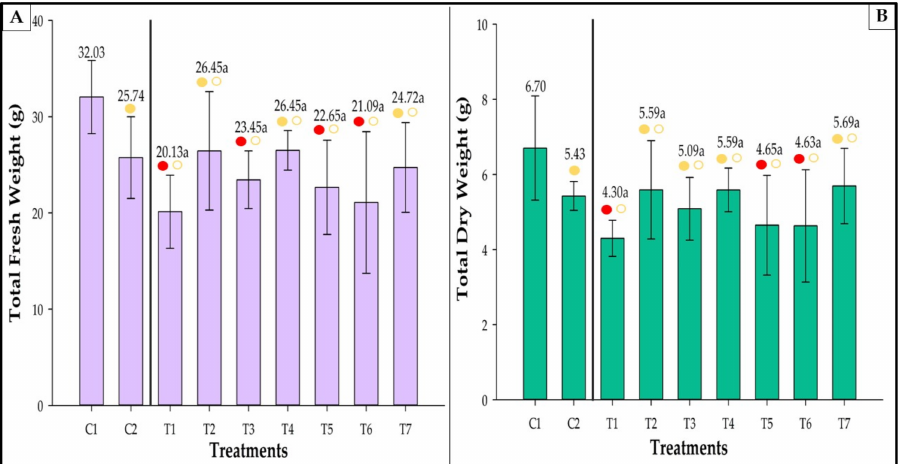
Figure 9. Total fresh ( A ) and dry ( B ) weights of strawberries inoculated with Azospirillum brasilense , Bacillus megaterium , and Brevibacillus fluminis , alone and in mixtures. Closed ( indicate comparisons withs Controls 1 and 2, respectively. Yellow and red circles indicate that the values are equivalent to, or lower than those observed in the controls according to Dunnet’s test ( p ≤ 0.05). Means followed by the same letter do not differ statistically according to Duncan’s test ( p ≤ 0.05). C1: control without inoculation + fertilization 100% of N and P; C2: control without inoculation + fertilization 30% of N and P; T1 : Azospirillum brasilense (Ab-v5); T2: Bacillus megaterium (0004); T3: Brevibacillus fluminis (MET12M2); T4: Ab-v5 + 0004; T5: Ab-v5 + MET12M2; T6: 0004 + MET12M2; T7: Ab-v5 + 0004 + MET12M2.